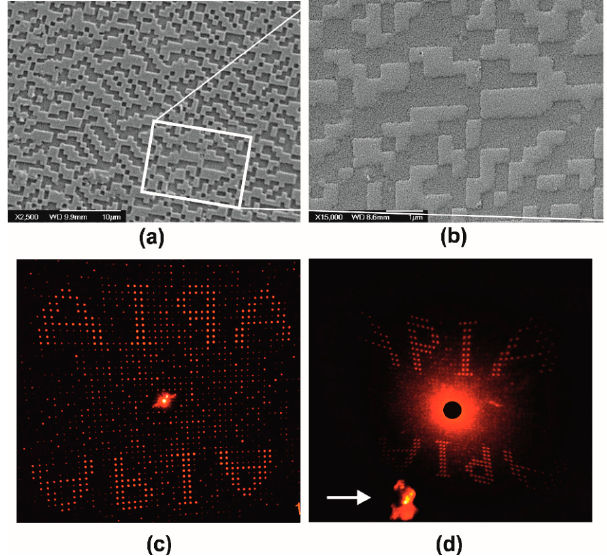
Figure 7. Stage I miniaturization of computer-generated surface relief hologram (CGH) in xerogel: ( a ) polymer resist master is a negative replica of the original structure on silicon; ( b ) SF ~2.5× downsized xerogel replica of the pattern in ( a ), where CGH structures were reconstructed by using a He-Ne laser beam operating at 633 nm; ( c ) reconstructed image of reflective CGH of the original silicon master; and ( d ) reconstructed image of transmission CGH xerogel replica in ( a ) indicated by a white arrow in image ( d ).